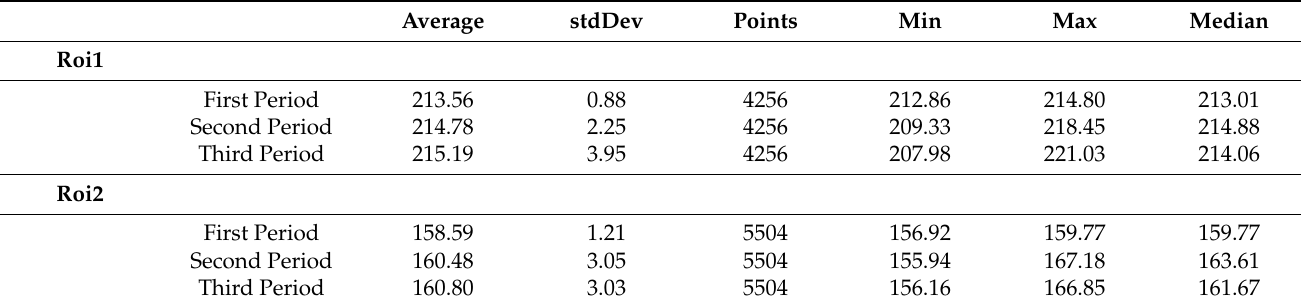
Table 3. The average values of dynamic blood-flow rate of skin microcirculation on the surface in three periods at two test points of a